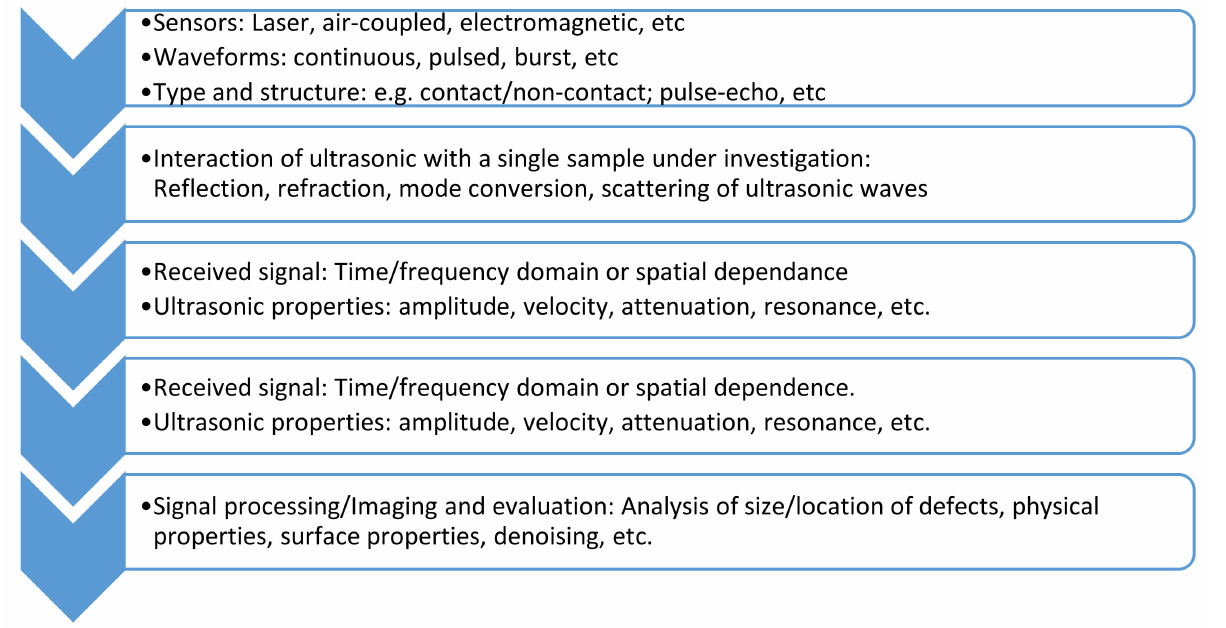
Figure 13. Ultrasonic measurement system